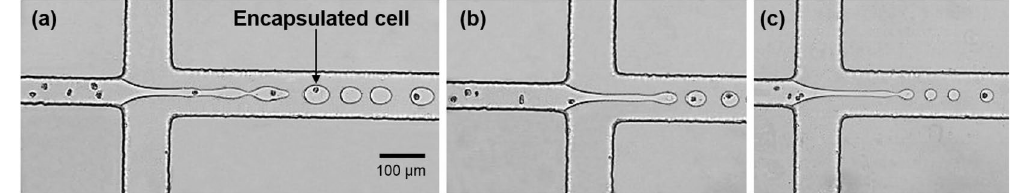
Figure 5. Representative images of cell encapsulation inside salt droplets in different sizes. ( a ) D = 42 μ m; ( b) D = 34 μ m; ( c ) D = 25 μ m.